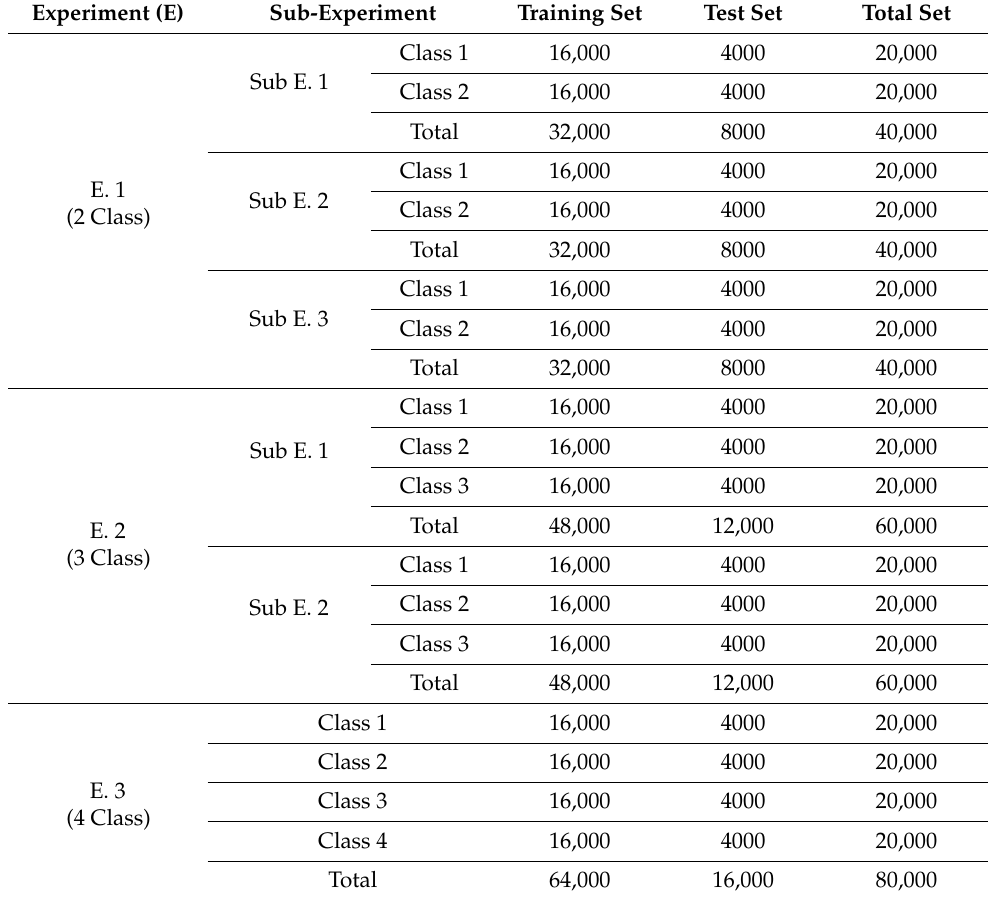
Table 4. Test and training dataset for the